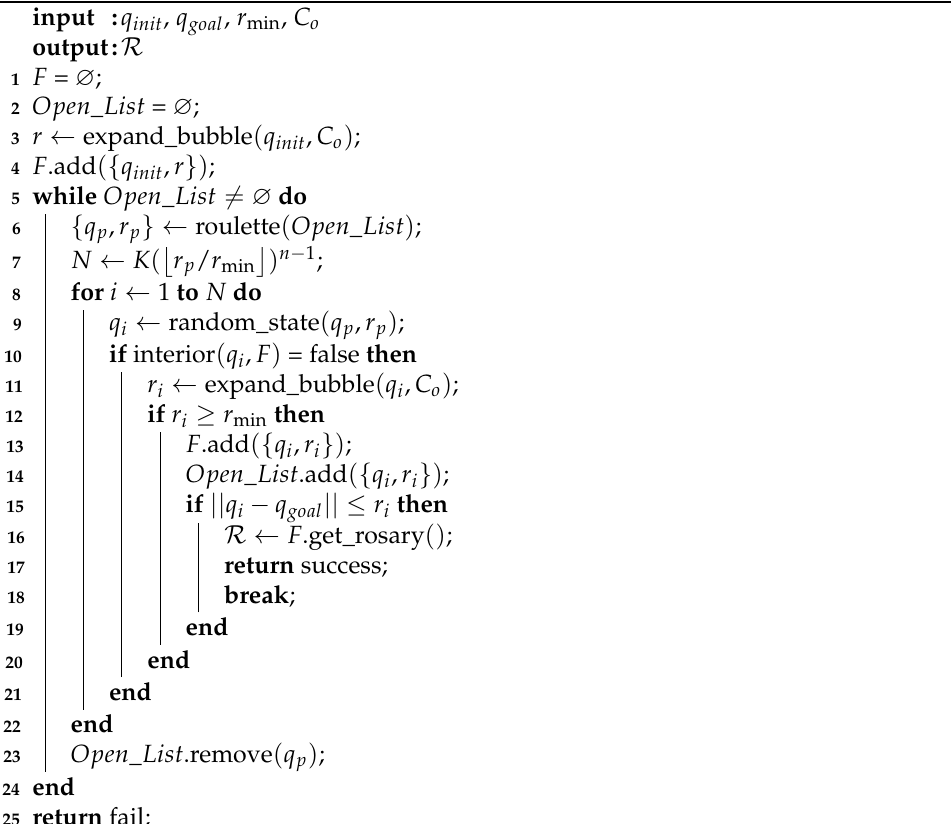
Algorithm 3: Radius-Biased Probabilistic